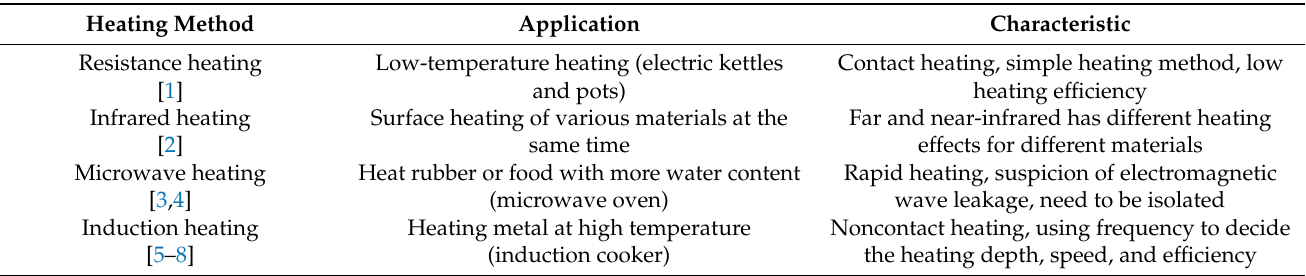
Table 1. Comparison among four heating